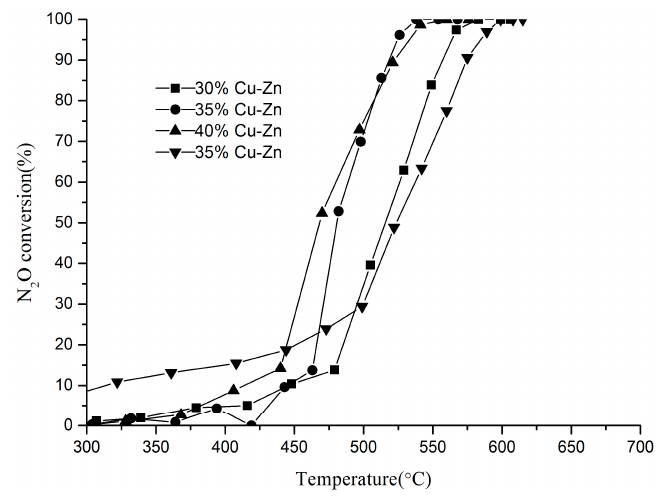
Figure 2. The effect of the Cu–Zn loading amount on the decomposition of N 2 O.